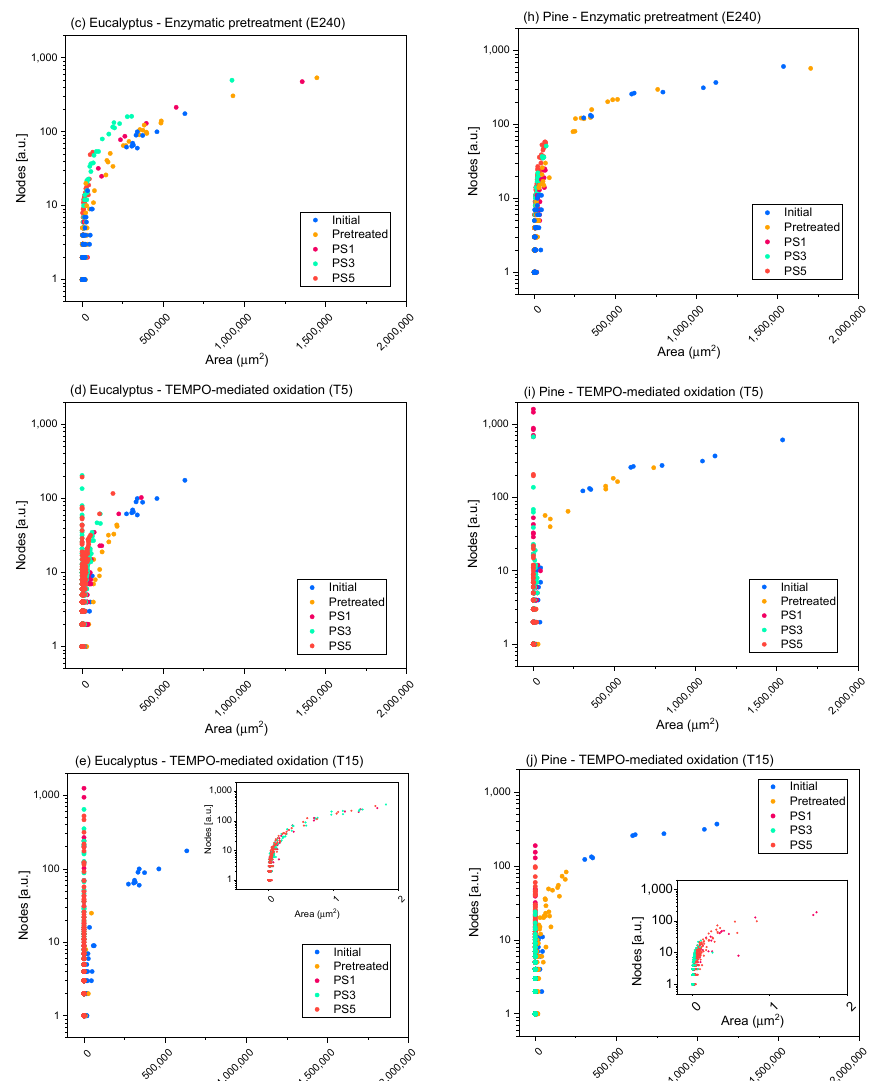
Figure 8. Evolution of the number of nodes quantified in the elements identified in the microscopy images with their projected area, when different pretreatments and pressure sequences are used to produce eucalypt ( a – e ) and pine cellulose ( f – j ) micro and nanofibers (CMF/CNFs). Mechani- cal pretreatment: ( a , f ); enzymatic pretreatment (E80): ( b , g ); enzymatic pretreatment (E240): ( c , h ); TEMPO-mediated oxidation (T5): ( d , i ); TEMPO-mediated oxidation (T15): ( e , j ). In the case of pine, given that the raw fibers were already highly ramified, the effect of refining on the nodes per area ratio was not as appreciable as in eucalyptus, since a smaller increment was observed in the number of nodes, while occupying the same area, as the OM images show. The high ramification after refining is also shown in hemp (Figure S3), while for jute and sisal, not only was an increase in the number of nodes observed, but also a reduction in the area of the elements due to the separation of some microfibrils from the primary structures. Moreover, the nodes/area ratio was maintained when severity